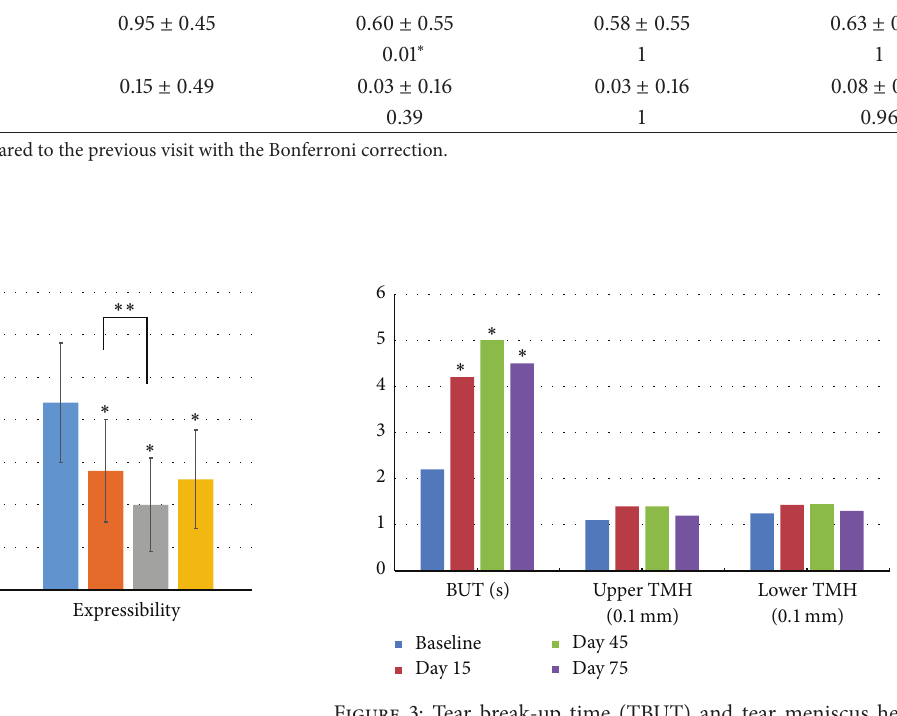
Figure 2: Meibomian gland secretion quality and expressibility.